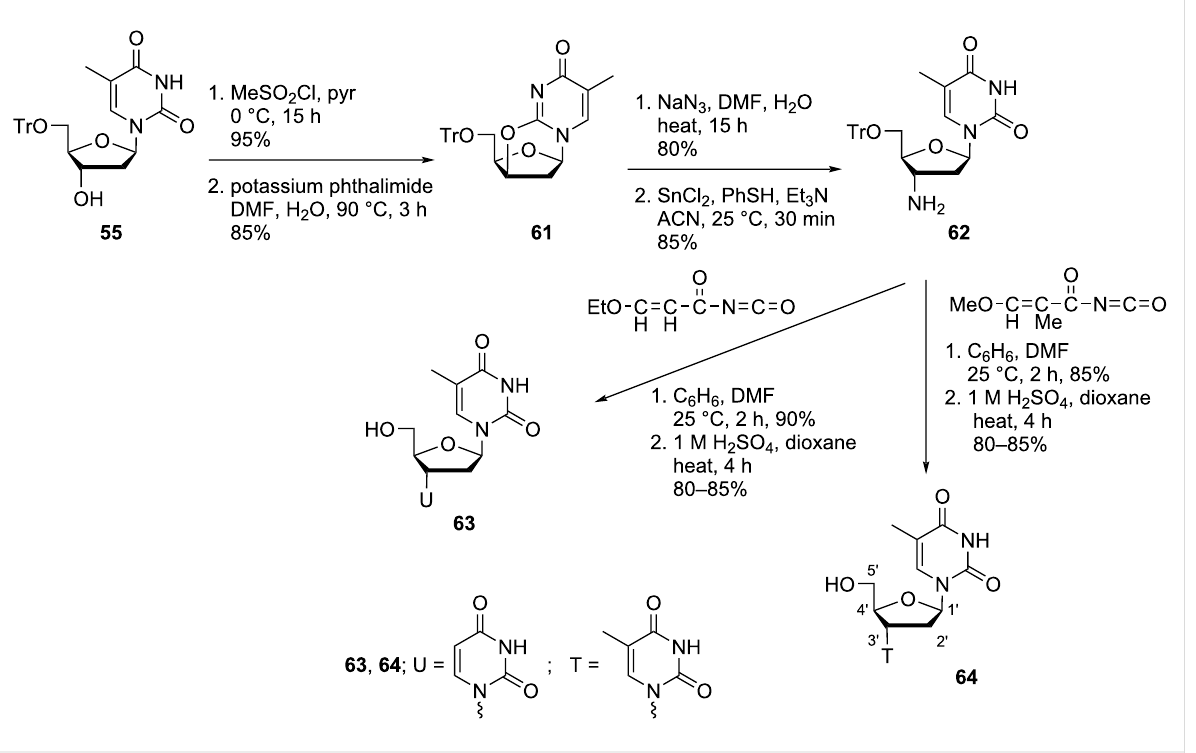
isopropylideneuridine ( 67 ) and 5 ′ -amino-2 ′ ,5 ′